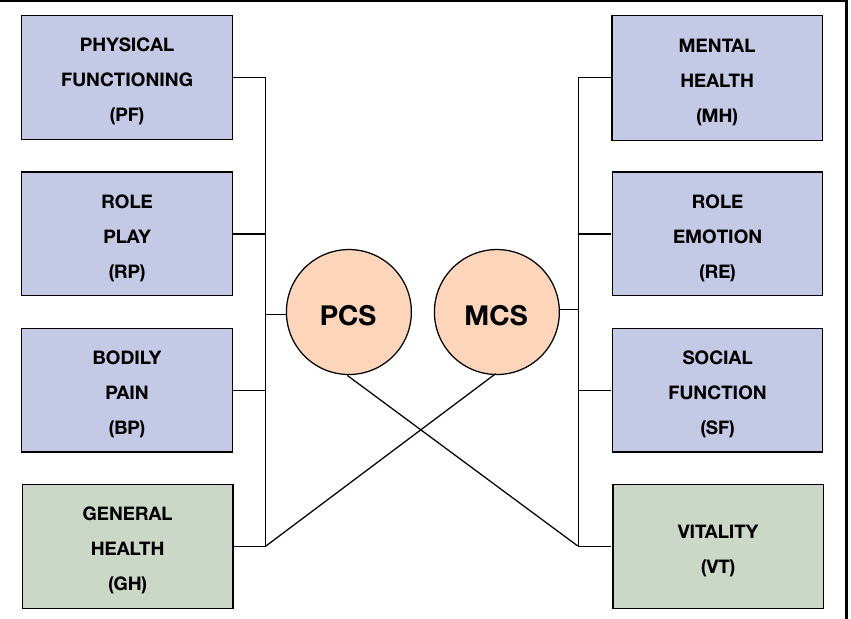
Figure 1: SF-36 Scales Measure Physical and Mental components of health (ware et al,